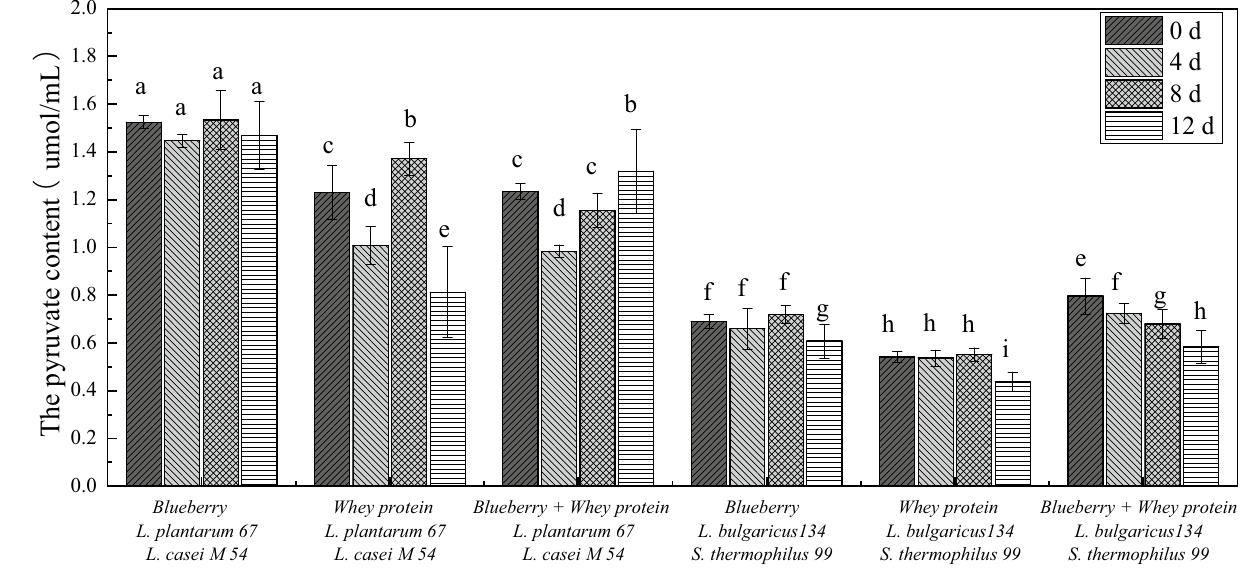
Figure 7. The pyruvate content in E. coli treated with whey protein and blueberry juice mixture system fermented with